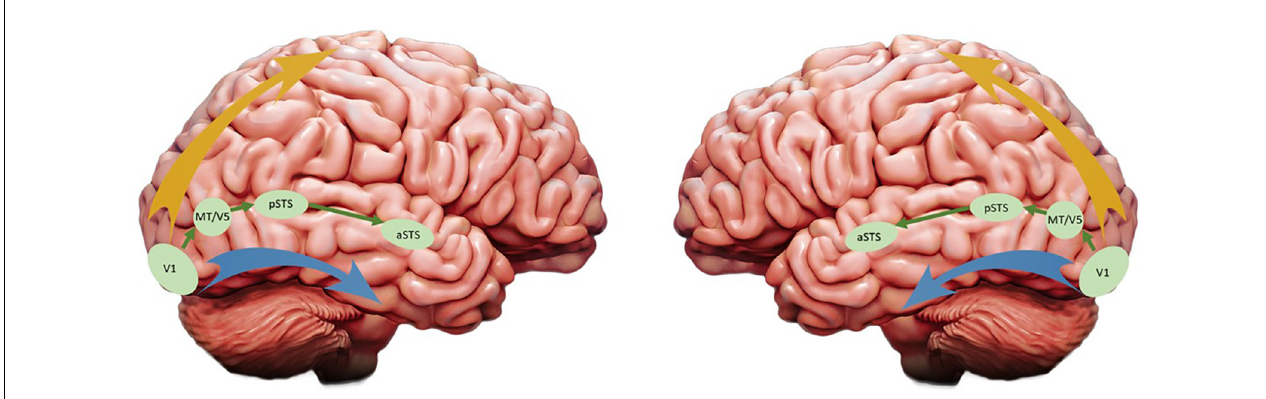
FIGURE 2 | Updated version of the visual streams model: The ventral and dorsal pathways are represented by the blue and yellow arrays, respectively, and the third visual pathway proposed by Pitcher and Ungerleider (2020) is depicted in green. While these authors emphasized the role of the third pathway in the right hemisphere (left panel), in this article we are focusing on its functions in the left hemisphere (right